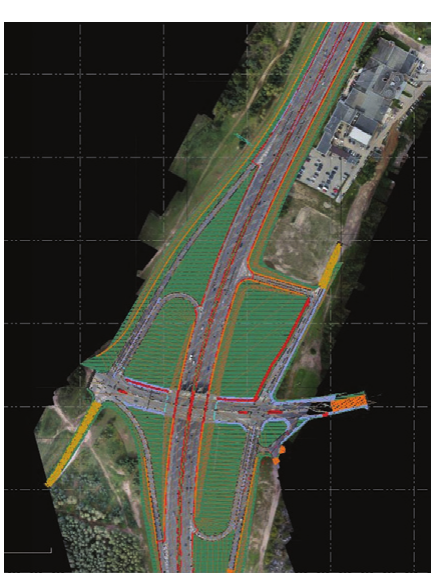
Fig. 8. Fragment of generated orthophoto with road (bypass) project data